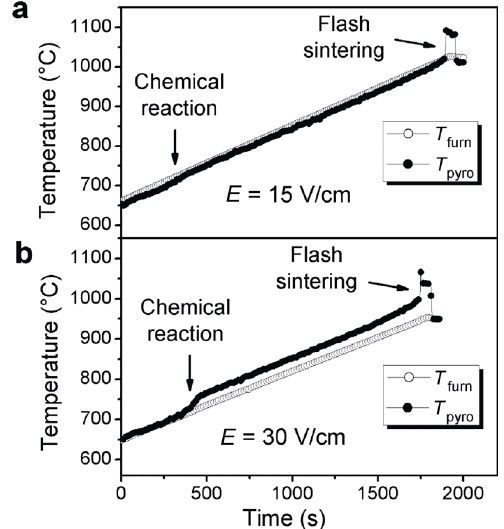
Fig. 8 Time evolution of the furnace versus pyrometry temperatures during fast O3S for powder processing under fields of (a) E = 15 V·cm − 1 and (b) E = 30 V·cm − 1 . The temperature measured using the pyrometer ( T pyro ) is, in comparison, supposed to better represent the real specimen temperature. The temperature regions of chemical reaction and flash sintering occurrence are indicated in both